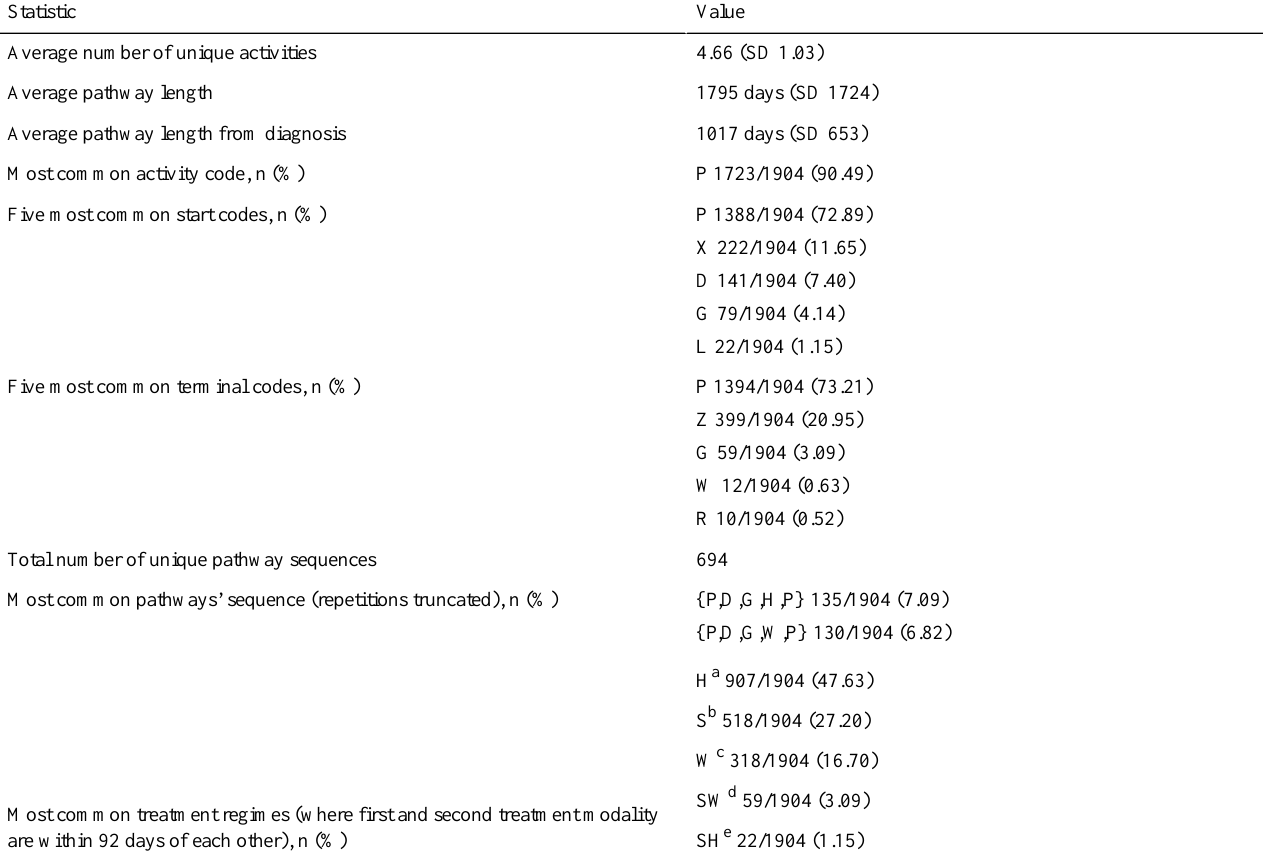
Table 5. Summary of pathway